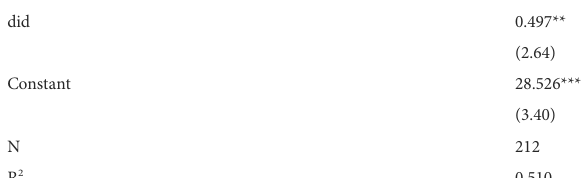
FIGURE 5 Results of placebo test.